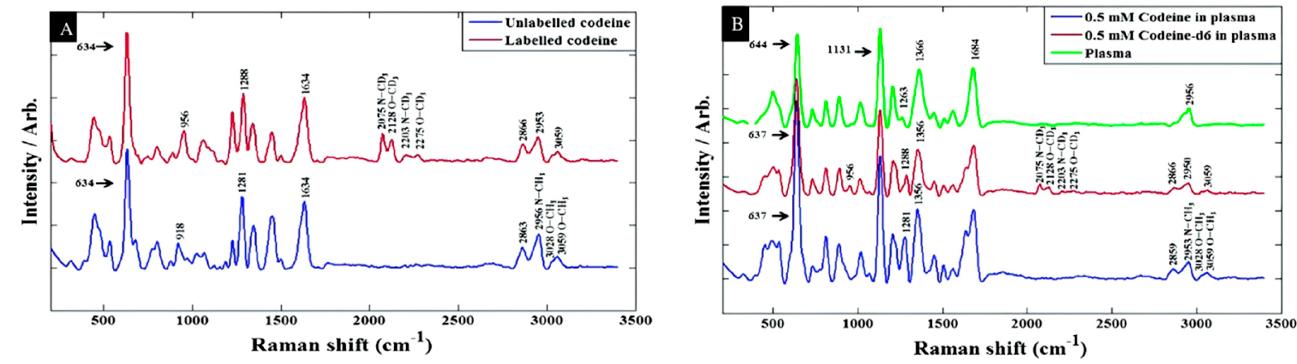
Figure 7. Baseline-corrected SERS spectra of 100 µ M codeine spiked into ( A ) water ( B ) human plasma [122].